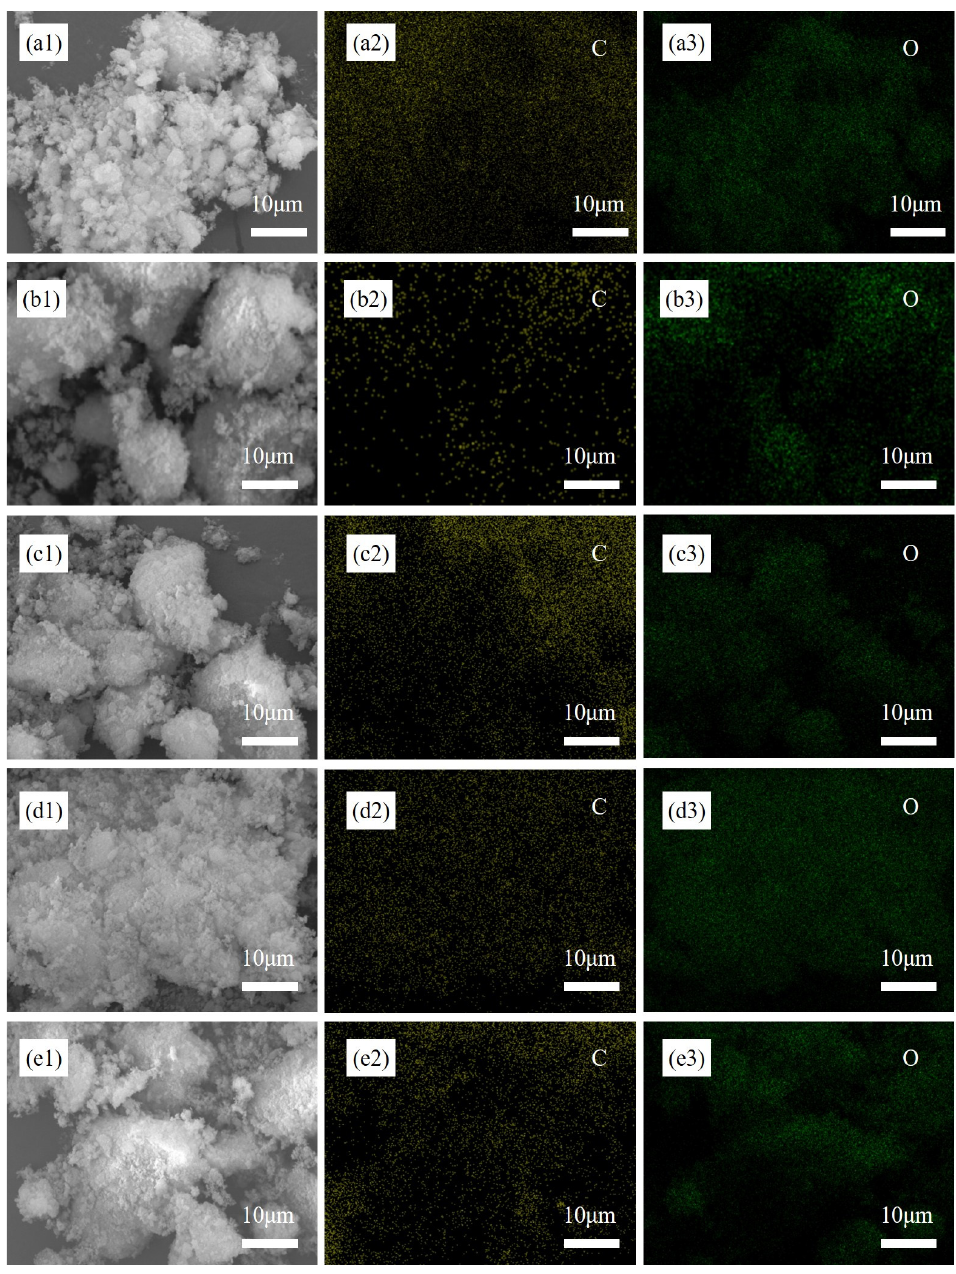
Figure 1. The SEM images and corresponded EDS mapping of Al 2 O 3 /C mixed powder with different contents of silane: ( a1 – a3 ) 0 wt%; ( b1 – b3 ) 2.5 wt%; ( c1 – c3 ) 5 wt%; ( d1 – d3 ) 7.5 wt%; ( e1 – e3 ) 10 wt%.